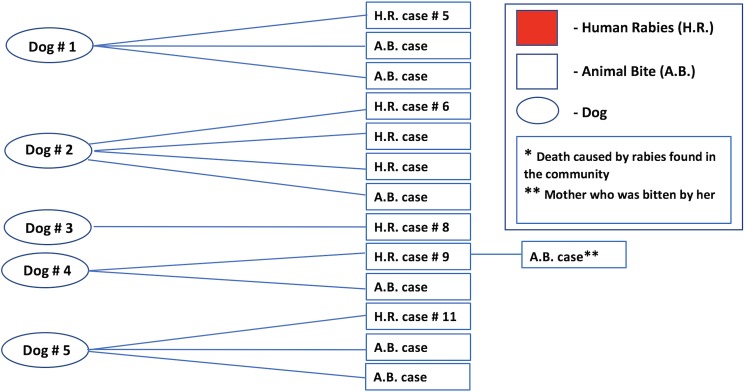
Epidemiological link between cases of human rabies admitted to Maputo Central Hospital and animal bite and human rabies cases identified at the community level.The left circles represent the dogs linked to cases initially identified at Maputo Central Hospital. The rectangles with numbered human rabies case (H.R. case #) inside at the right represent human rabies cases identified at Maputo Central Hospital. The rectangles at the right with non numbered human rabies case (H.R. case) or animal bite (A.B. case) represents cases of human rabies and animal bites identified during the community investigation.